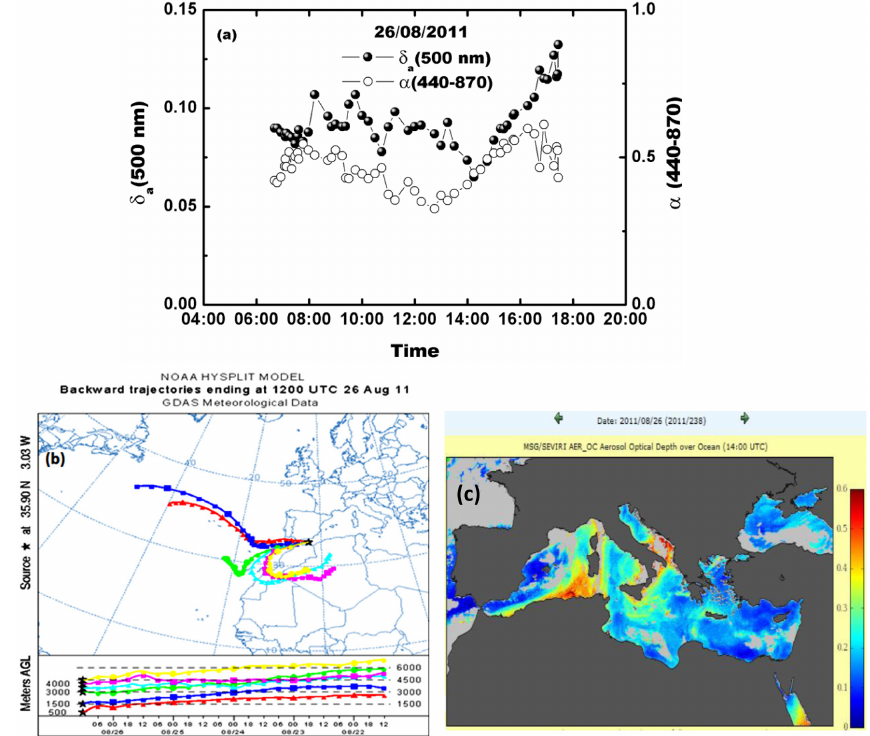
Figure 3. (a) Aerosol optical depth at 500nm and Ångstrom exponent in the range 440–870nm, (b) backward trajectories ending at 12 UTC over Alborán Island at height altitudes of 500, 1500, 3000 and 4000m, (c) MSG satellite image for 26 August 2011 (http://www.icare.